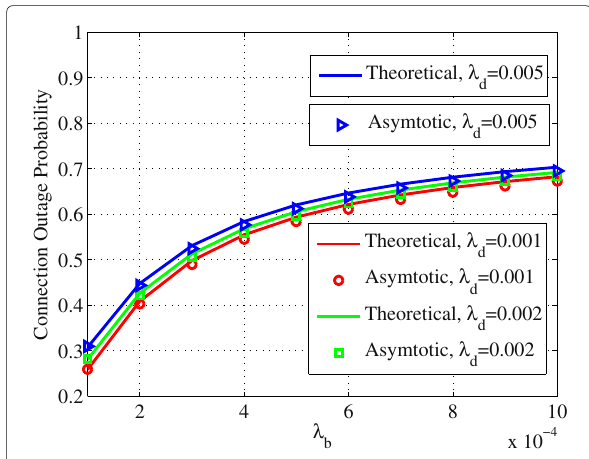
Fig. 8 The connection outage probability of the typical D2D link versusthedensityofthebasestation λ b where φ = 0.3, R d = 1 bps / Hz . Figure 8 represents the close-form expression and asymptotic expression of connection outage probability of the typical D2D link